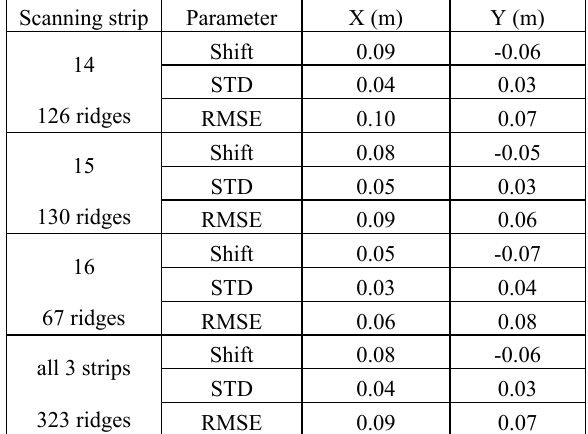
Table 3. The result of measurements of roof ridges from 3D building